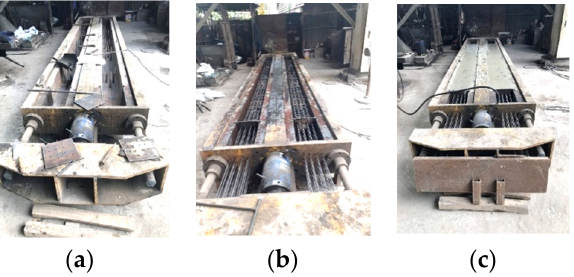
Figure 4. Manufacturing of the PSB samples in the factory. ( a ) Preparing the molds; ( b ) Pre-tensioning of the strands; ( c ) Concreting into the molds.